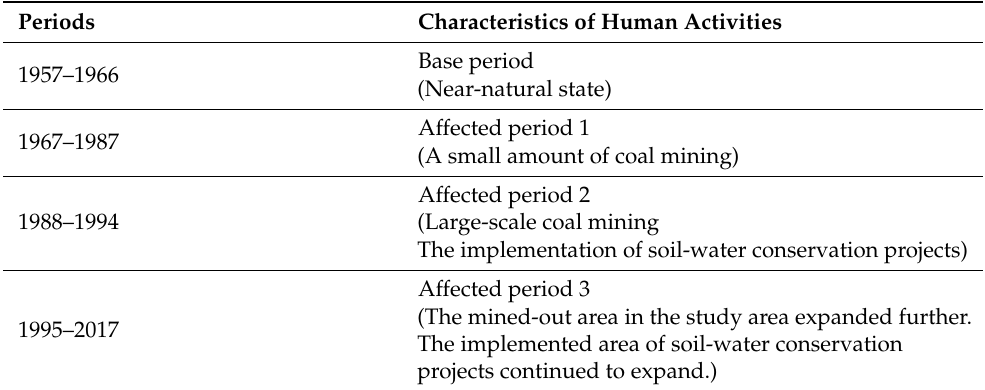
Table 1. Four different periods and characteristics of human